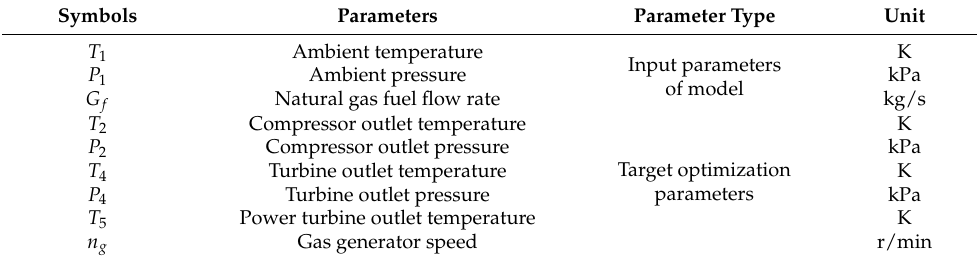
Table 2. The gas turbine measurable parameters.